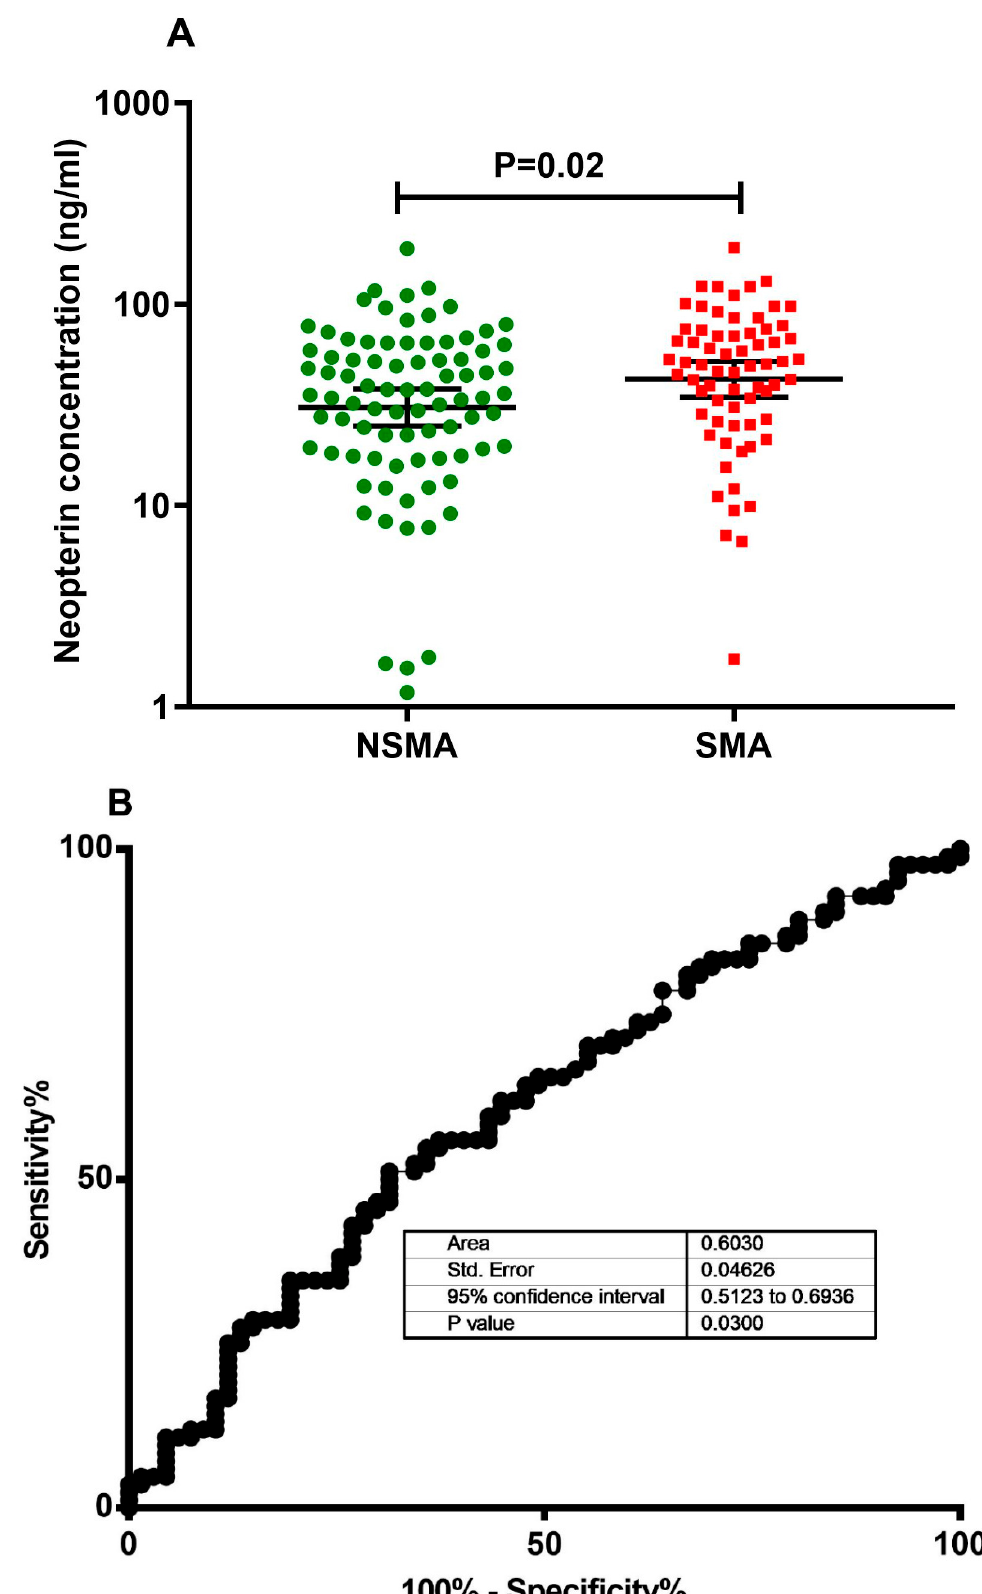
Figure 2. ( A ) Plasma levels of neopterin among children with SMA, as defined by Hb levels < 5g/dL, and children without SMA, as defined by Hb levels > 5g/dL, and ( B ) ROC curve analysis predicting neopterin’s performance in differentiating SMA from NSMA.